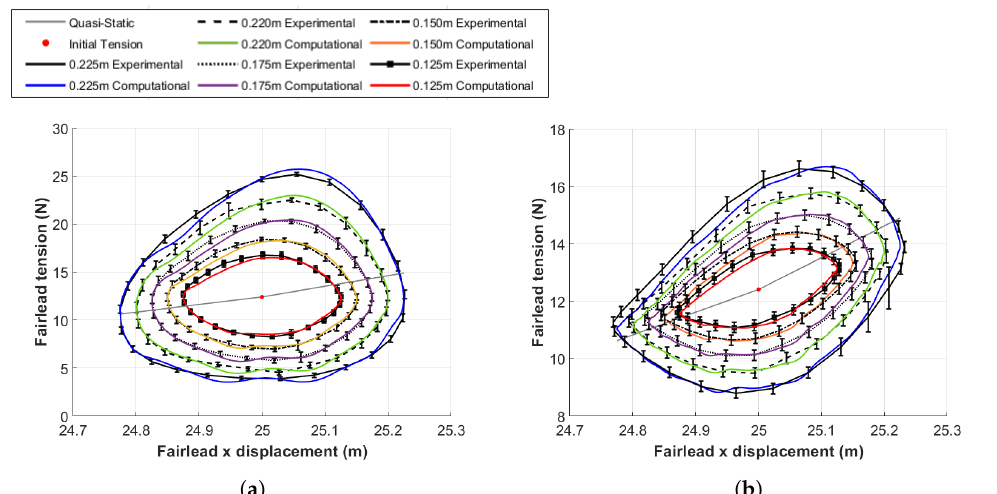
Figure 25. Comparison between the computed fairlead tension values and the experimental mea- surements with clumped weight in configuration 2 for different oscillation amplitudes A = 0.225, 0.220, 0.175, 0.150, 0.125 m and two different periods T = 2.8, 5.5 s for the isolated mooring line. ( a ) T = 2.8 s. ( b ) T = 5.5 s.